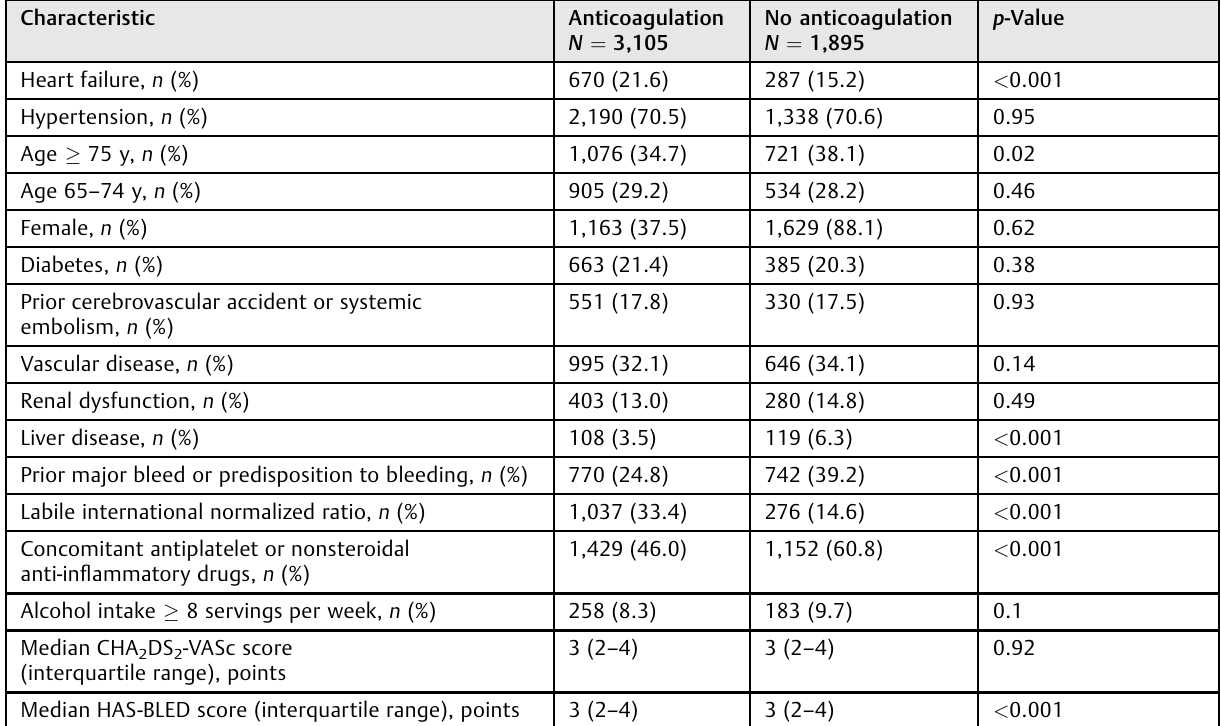
Table 3 Assessment of stroke and bleeding risk in patients receiving anticoagulation compared with those who were